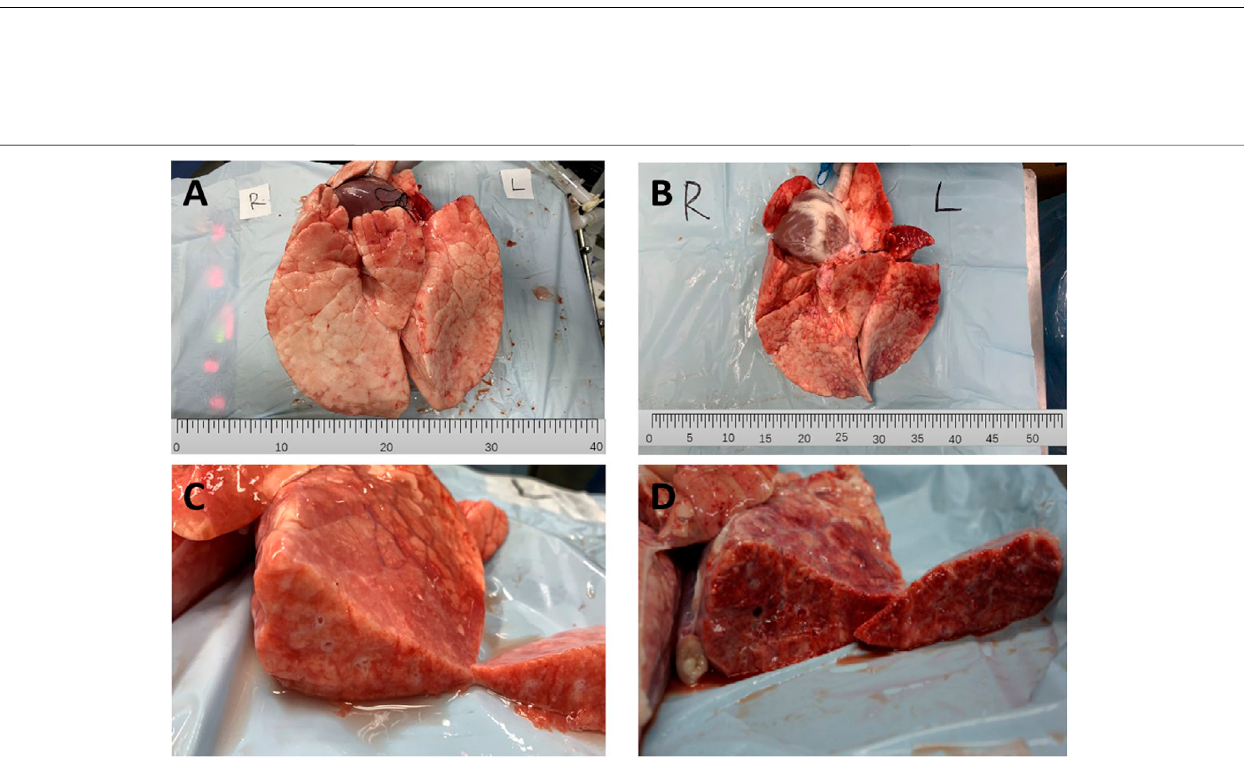
FIGURE 2 | Gross pathological changes of lung tissues. Representative specimens of the gross lung form of APRV and LTV groups are shown. (A) APRV whole lung; (B) LTV whole lung; (C) APRV cut surface; (D) LTV cut surface. APRV, airway pressure release ventilation; LTV, low tidal volume ventilation.